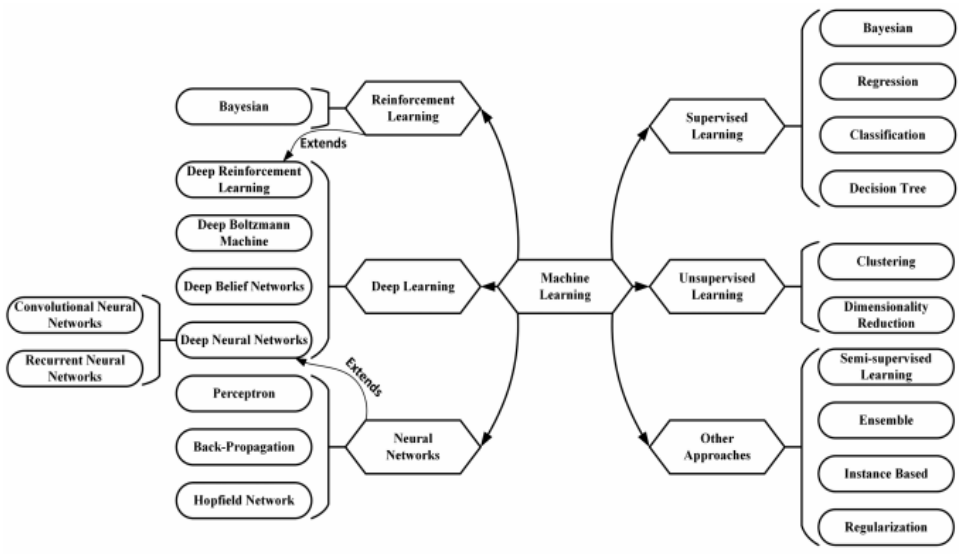
Figure 1. Machine Learning Overall Category.